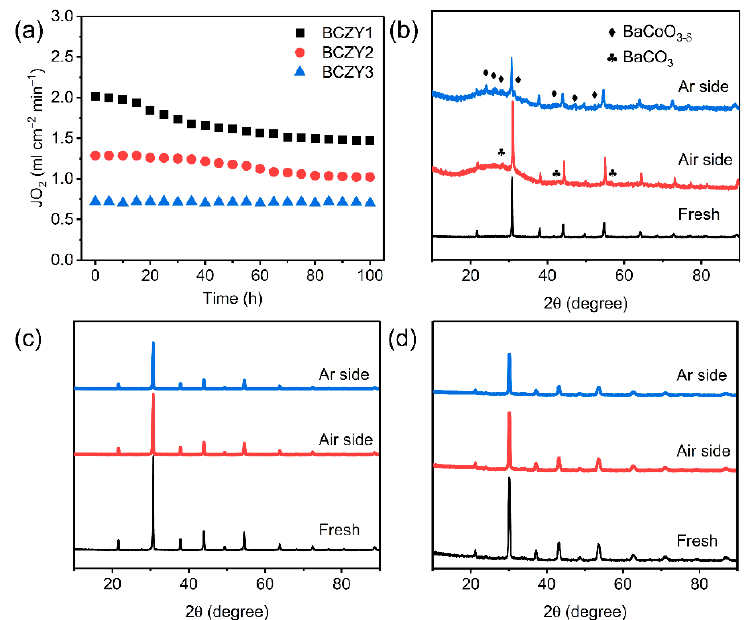
Figure 6. ( a ) Oxygen permeation stability tests of 0.8 mm-thick BCZY1, BCZY2 and BCZY3 mem- branes at 800 °C; RT-XRD patterns of BCZY membranes after the 100 h’s oxygen permeation: ( b ) branes at 800 ◦ C; RT-XRD patterns of BCZY membranes after the 100 h’s oxygen permeation: BCZY1, ( c ) BCZY2 and ( d ) BCZY3. ( b ) BCZY1, ( c ) BCZY2 and ( d )